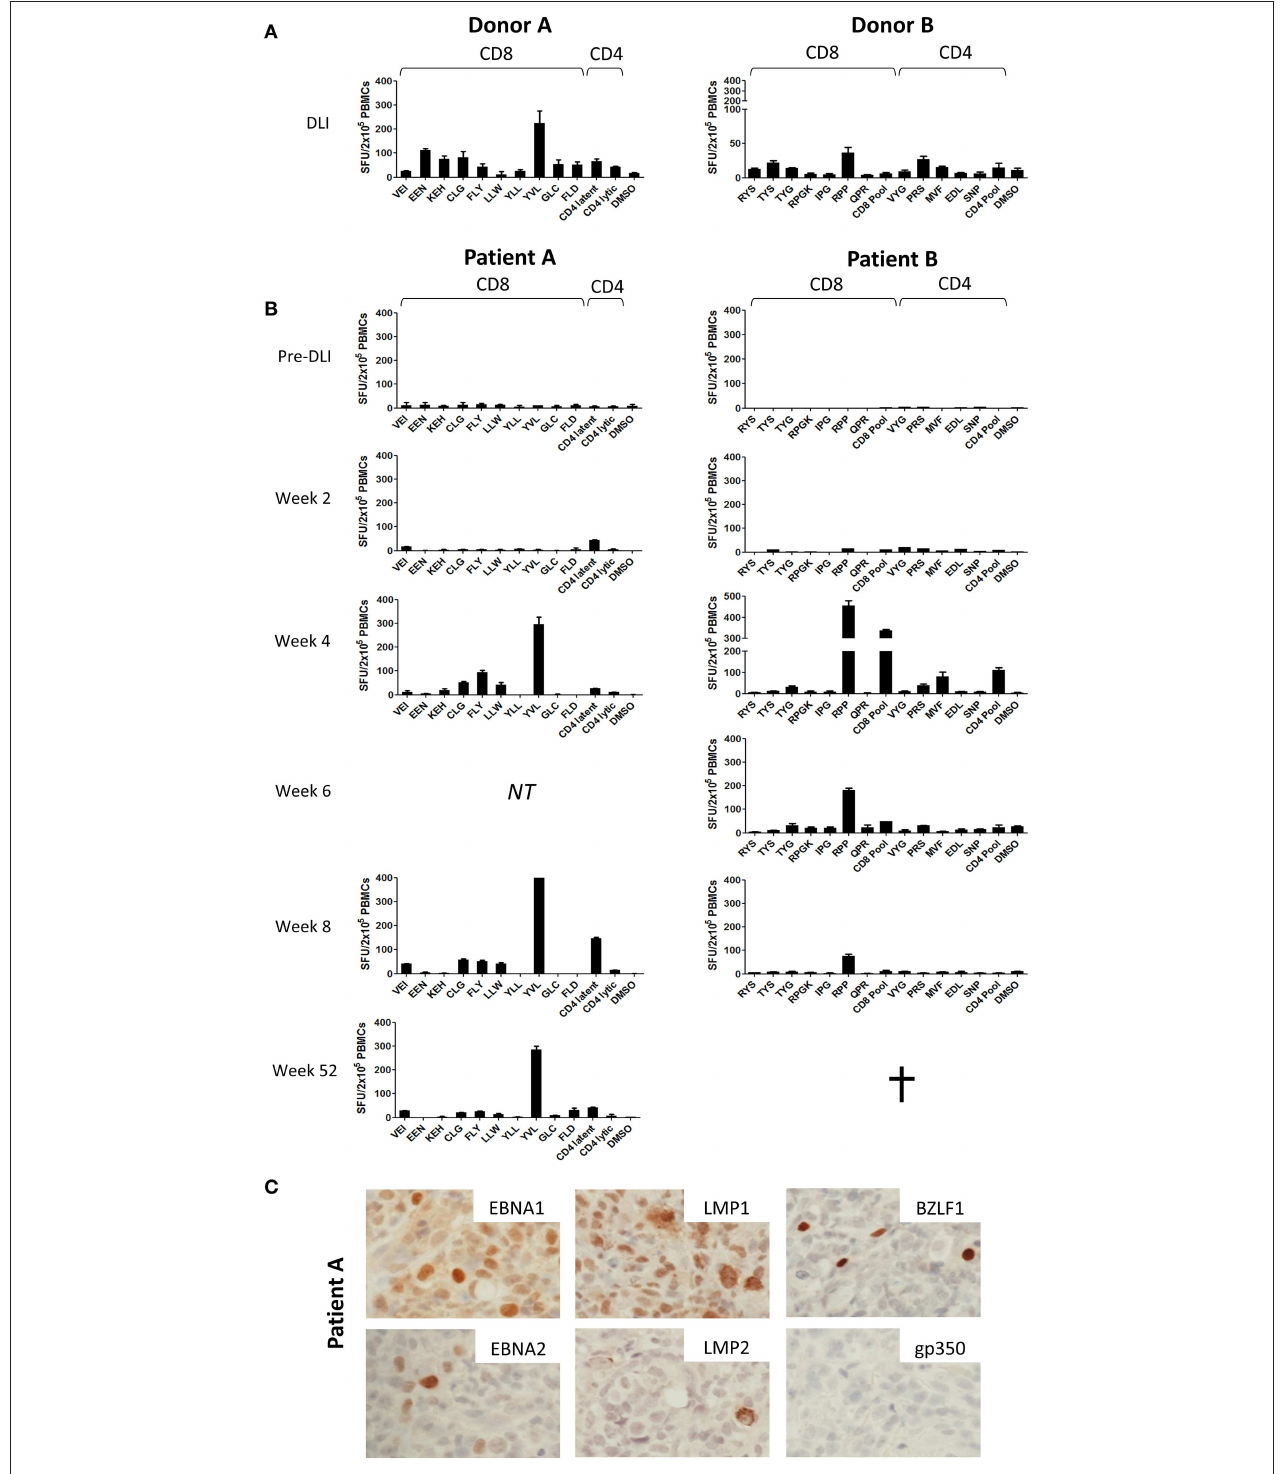
FIGURE 2 | Prospective analysis of EBV epitope-specific T-cell responses. Aliquots of the infused DLI (A) or PBMCs from serially collected samples from patients A and B (B) were stimulated overnight with selected panels of CD8 + and CD4 + epitope peptides of relevant HLA class I and class II restriction ( Tables S1 , S2 ) before enumeration of responding cells using IFN- γ Elispot. Results shown are the mean spot forming units (SFUs) per 2 × 10 5 cells from duplicate or triplicate wells + /– SD. (C) Immunohistochemistry analysis of Formalin-fixed, paraffin-embedded diagnosis biopsy sections from Patient A, showing strong positivity for latent EBV antigens EBNA1, EBNA2, LMP1, and LMP2 and the lytic EBV antigen BZLF1 but absence of the late lytic cycle antigen gp350. Images are 60X magnified.